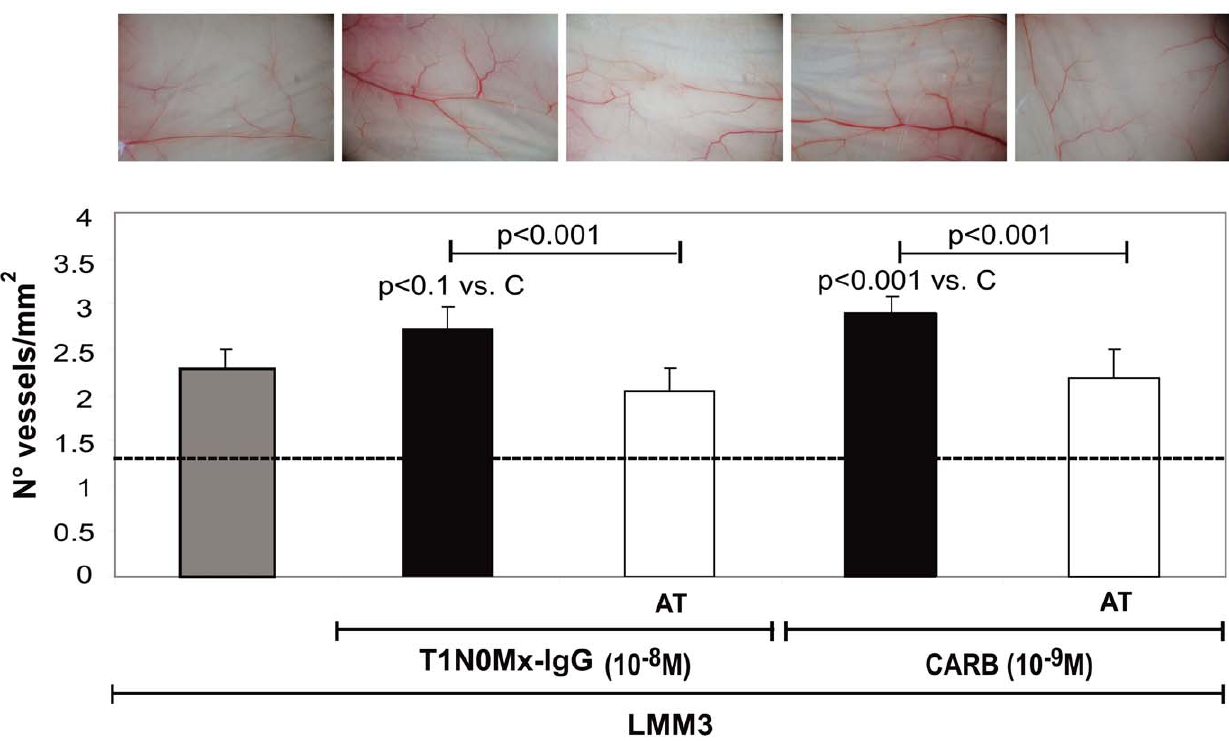
Figure 6. Effect of T1N0Mx-IgG or carbachol on LMM3 cells-induced angiogenesis. Cells were adjusted to 2 6 10 6 cells/ml and treated during 1 h with T1N0Mx-IgG (10 2 8 M) or carbachol (CARB) (10 2 9 M) in the absence or presence of 10 2 8 M atropine (AT). Cell suspensions (0.1 ml) were inoculated (i.d.) in both flanks of BALB/c mice. Values are means 6 S.E. of three experiments performed in triplicate. Basal: animals without treatment. Photographs of the angiogenic sites from each experimental group are shown in upper panels. Magnification 6.4 6